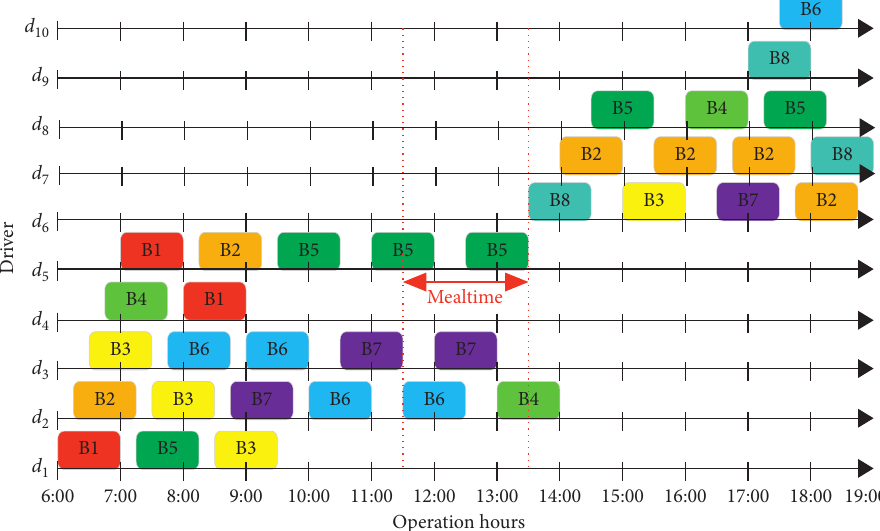
Figure 4: The optimal bus-driver-trip assignment.